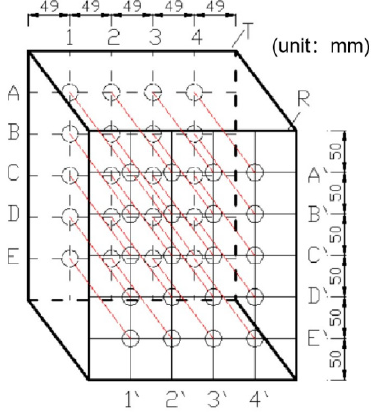
Figure 8. Measurement points.